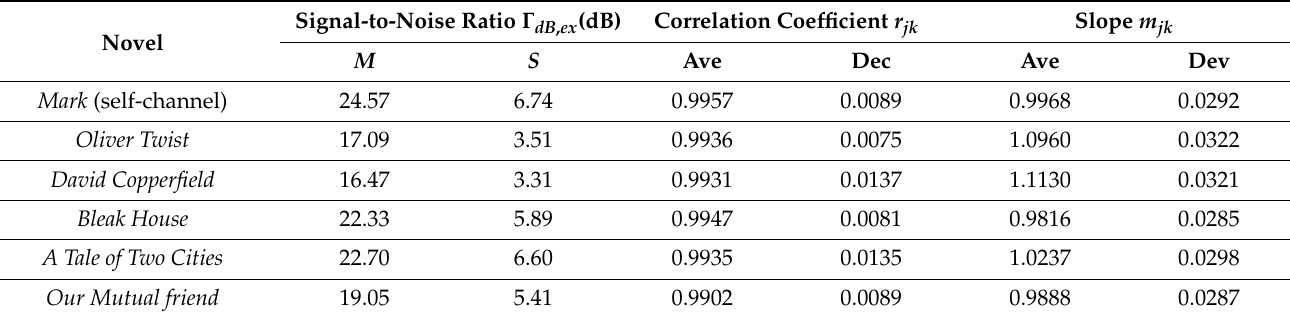
Table A1. Average value M (dB) and standard deviation S (dB) of Γ dB , ex (dB) in self- and cross- channels, correlation coefficient r jk , and slope m jk of the regression line between the number of sentences n S of Mark (channel output, self-channel) versus the number of sentences n S in Dickens’ novels (channel input, cross-channels), for equal number of words, in the sentences channel.